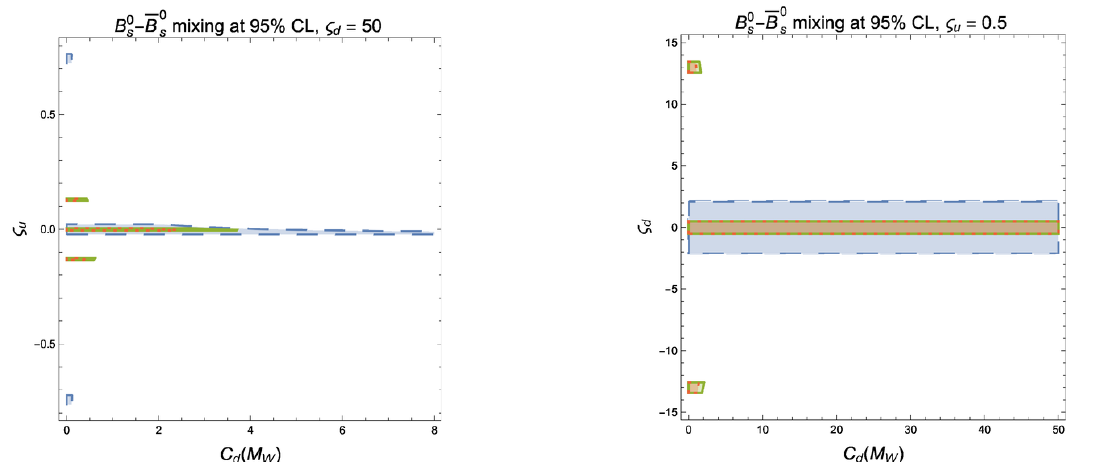
Figure 7. The left (right) panel shows the B 0 (cid:12)xed value of & d = 50 ( & u = 0 : 5), in the CP-conserving limit and with di(cid:11)erent mass con(cid:12)gurations: A (red, dotted), B (green, solid line) and C/D (blue,